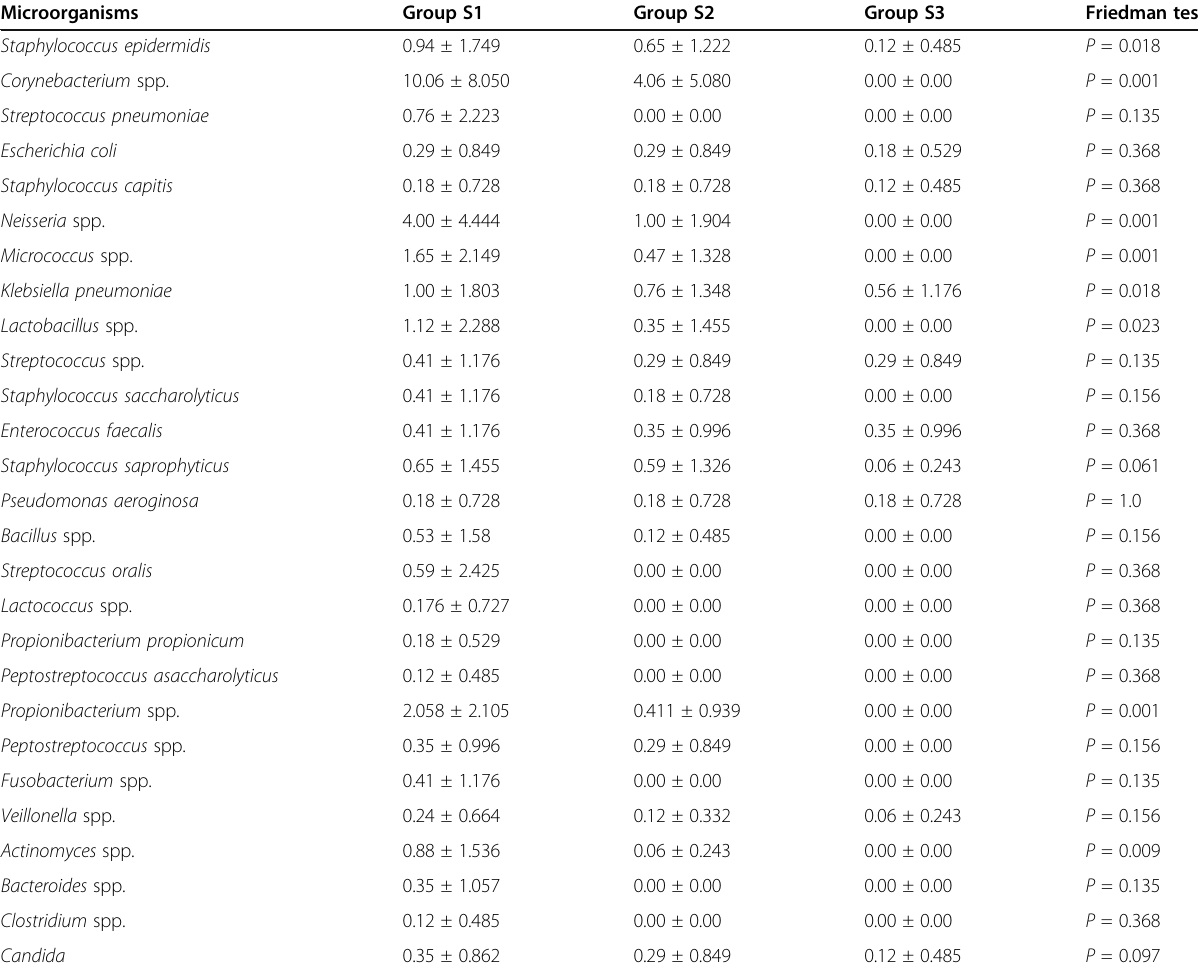
Table 2 Comparison of the mean colony forming units of total microorganisms among the three groups Microorganisms